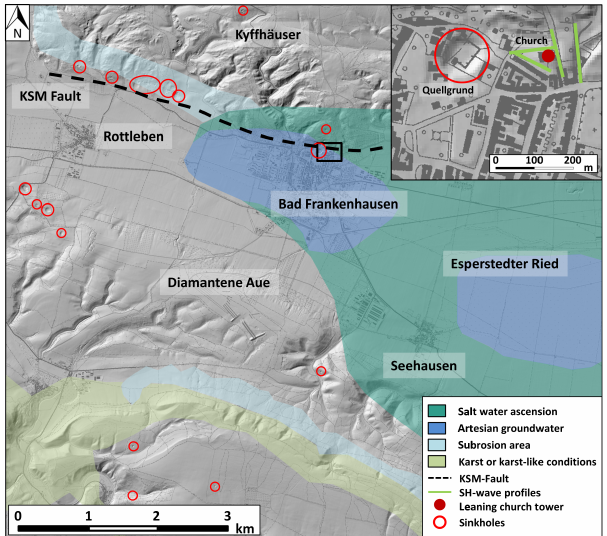
Figure 2. Digital elevation model showing the hydrogeological as- sessment of Bad Frankenhausen and the surrounding areas (pro- vided by Thuringian State Institute of Environment and Geology, 2016; Sven Schmidt, personal communication, 2016). The city of Bad Frankenhausen is located in a region of saltwater ascension and artesian groundwater conditions along the Kyffhäuser South- ern Margin Fault (dashed line). The research area with the leaning church tower of the “Oberkirche” (red dot) and the shear-wave seis- mic reflection profiles (light green lines) are shown detailed in the inset. A zone influenced by subrosion is defined based on the occur- rence of a line of sinkholes (red circles).